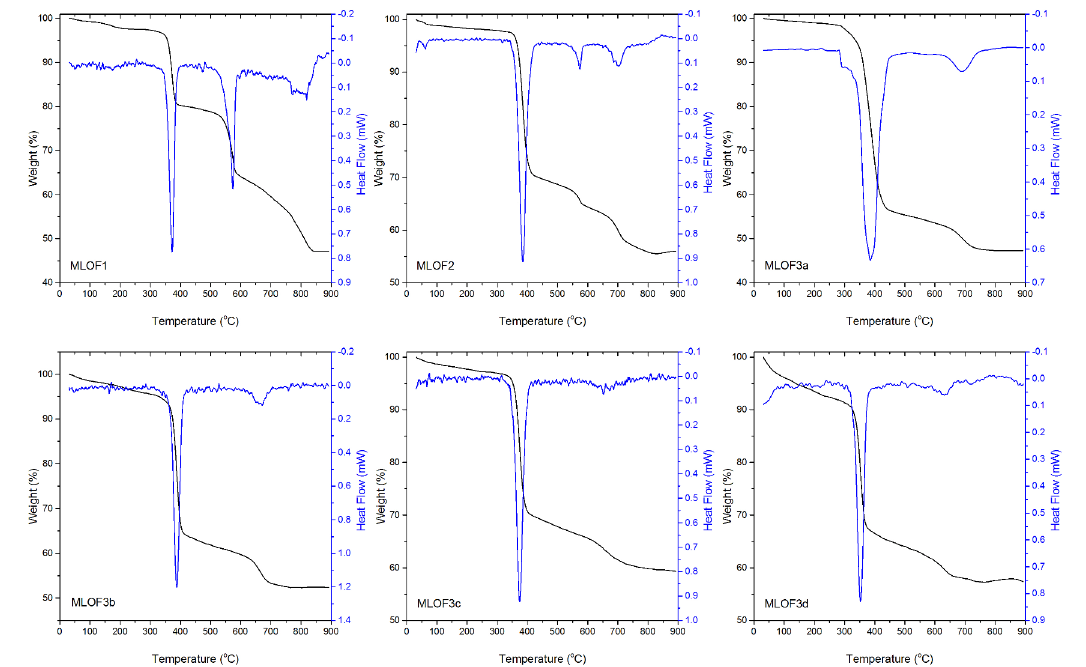
Figure 4. TG/DTA profiles of MLOF